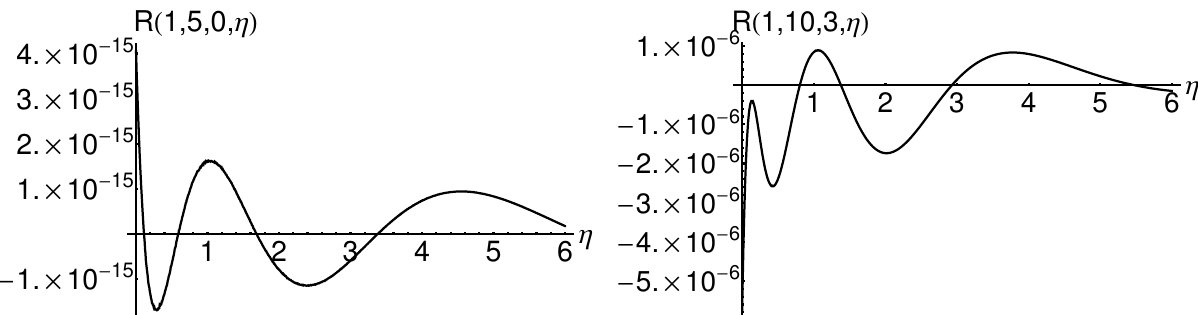
Figure 12: The residual R (1, 5, 0, η ) for Eq. (48) obtained by OAFM